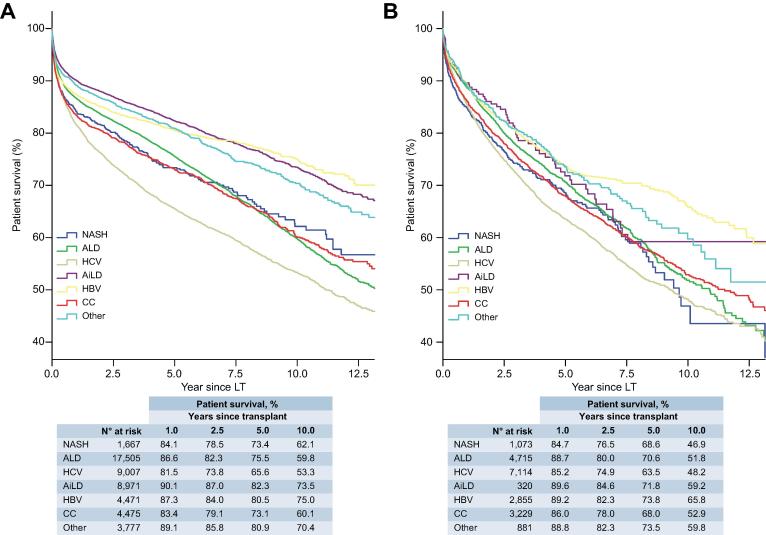
Survival analysis for patients undergoing primary liver transplantation for different indications. Kaplan-Meier curves of patient survival for cases without (A), and with (B) HCC (log-rank: p <0.001 for both). AiLD, autoimmune liver disease; ALD, alcohol-related liver disease; CC, cryptogenic cirrhosis; ELTR, European Liver Transplant Registry; HBV, hepatitis B virus infection; HCV, hepatitis C virus infection; LT, liver transplant; NASH, non-alcoholic steatohepatitis. (This figure appears in colour on the web.)